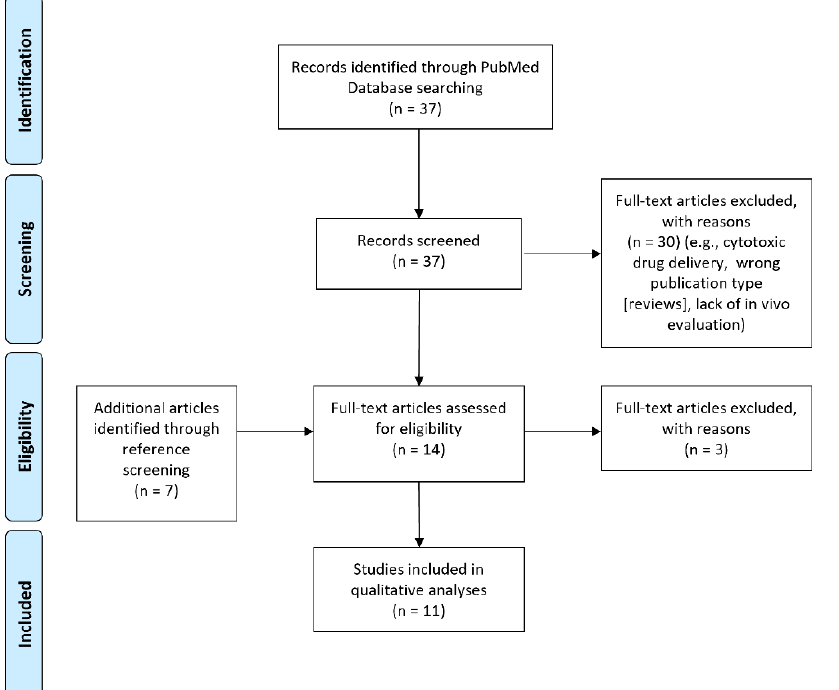
Figure 4. PRISMA flowchart showing study selection. PRISMA: Preferred Reporting Items for Systematic Reviews and Meta-analyses.